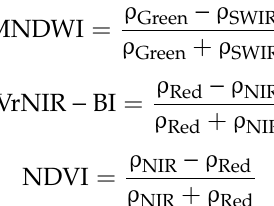
Table 1. Composition of Bands for Landsat 5 TM, Landsat 7 ETM+ and Landsat 8 OLI/TIRS satellites.